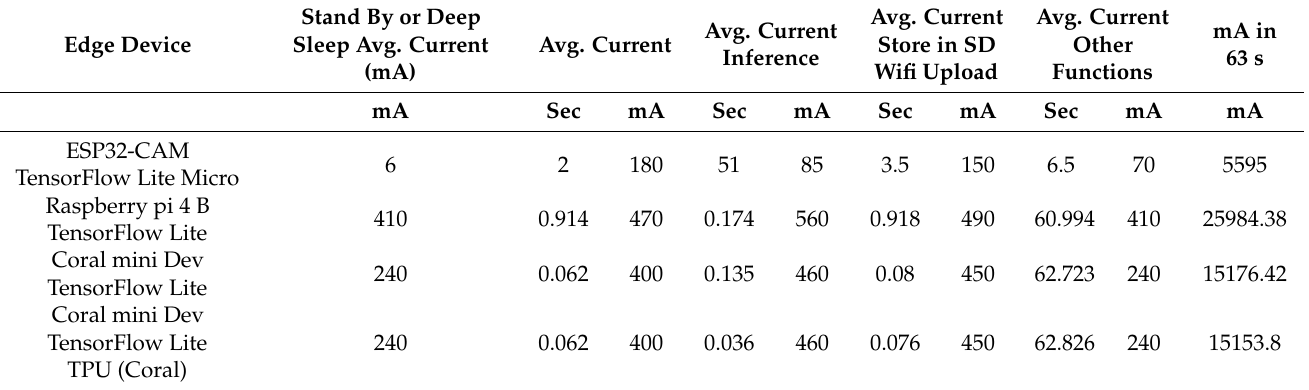
Table 5. Power consumption for key tasks. First column: Standby and deep sleep Average